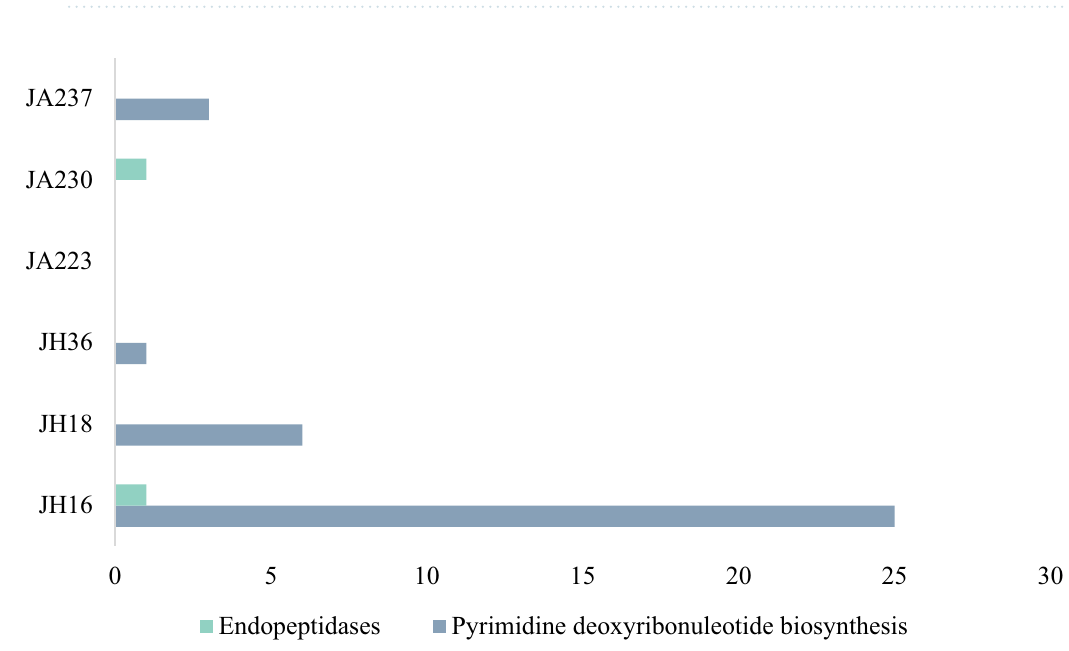
Figure 3. Abundance of putative hosts in six samples. Three individuals from Jakun Orang Asli (JA223, JA230, JA237) and three individuals from Jehai Orang Asli (JH16, JH18, JH36) taxonomy assigned from GDVT, expressed as counts of putative bacteria depending on viral abundance.